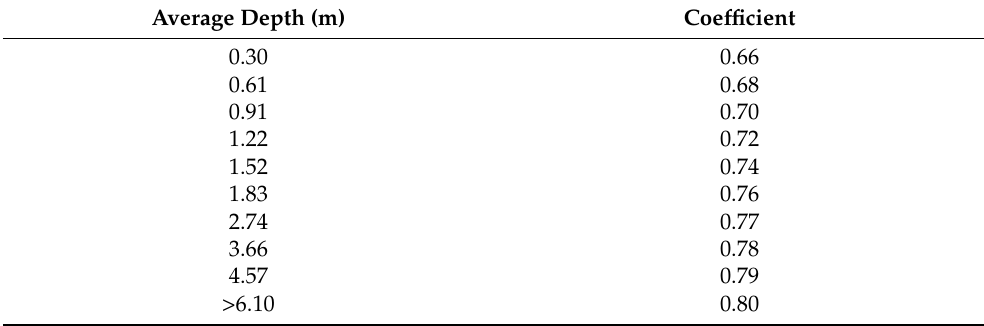
Table 1. Coefficients to correct surface float velocities to average channel velocities [18].